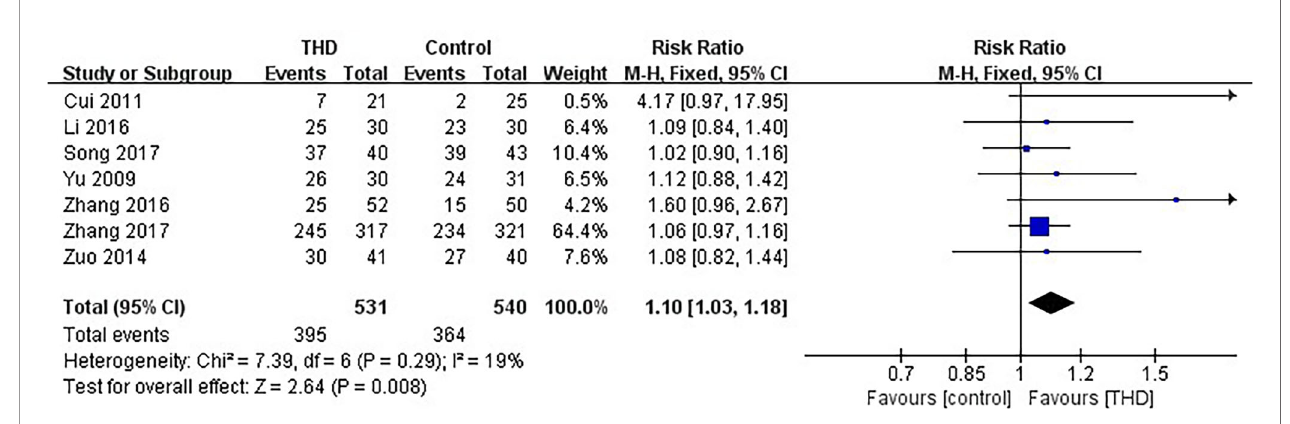
FIGURE 3 | Meta-analysis on CR (acute phase).